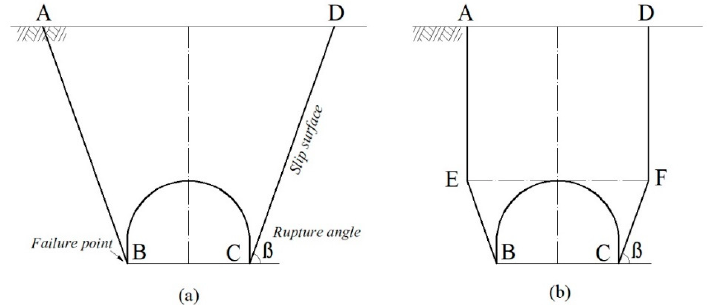
Figure 2. Schematic diagram of the surrounding rock slide surface: ( a ) Slide surfaces proposed by A. Bierbaumer and K. Terzaghi [6,7]; ( b ) Slide surfaces proposed.